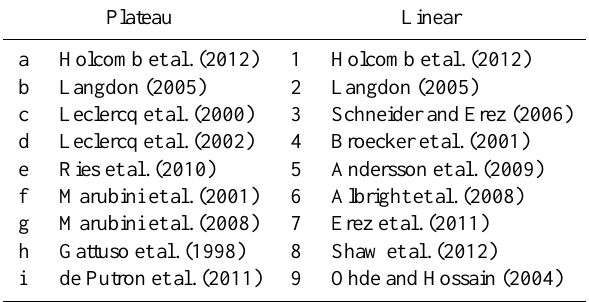
Table 1. Sources of data for experimental results in Fig. 1 Plateau